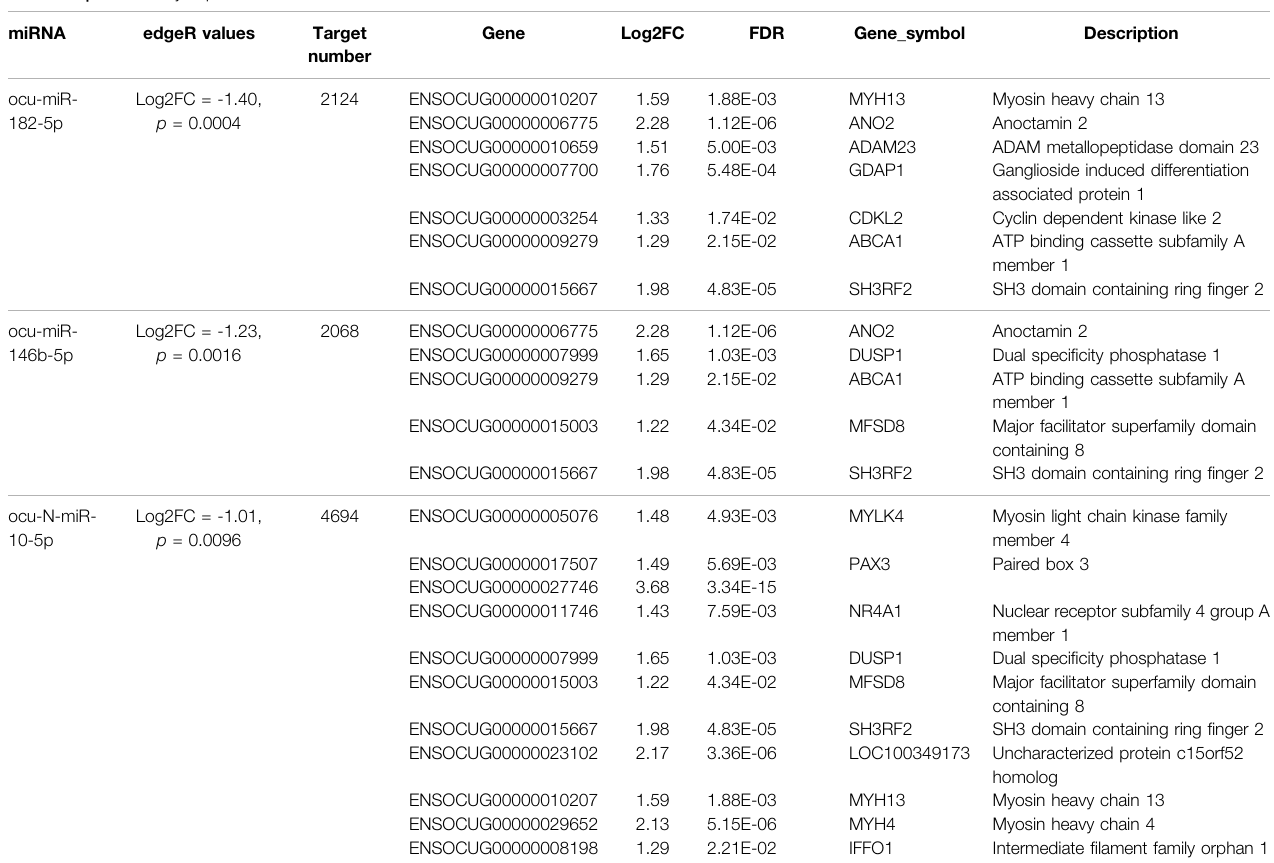
TABLE 2 | Differentially expressed miRNAs in the muscle tissues of SCWrabs and ZIKArabs. miRNA edgeR